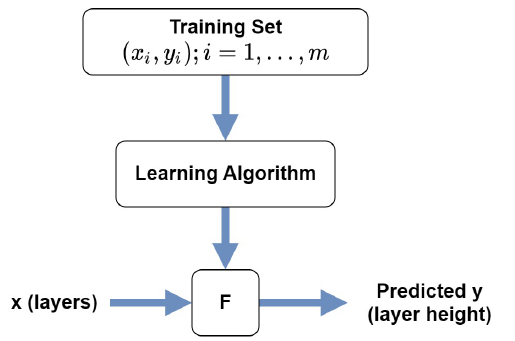
Figure 4. Bead height prediction